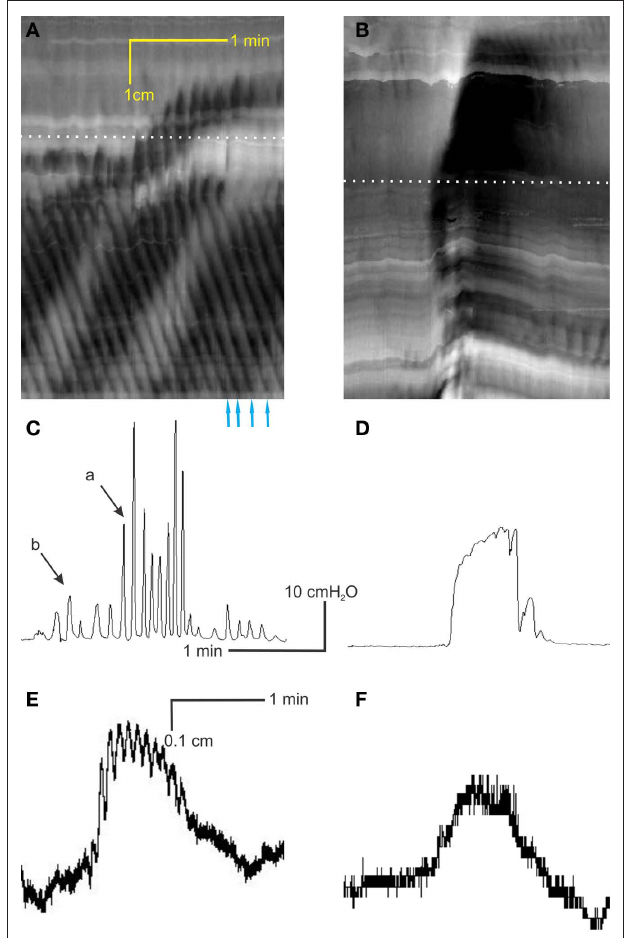
FIgurE 2 | Interaction between the two motor patterns. (A) The rhythmic propagating ripples are part of the rhythmic propulsive motor complexes. One can see a marked increase in amplitude (blackness) of the ripple contractions within the rhythmic propulsive motor complexes as compared to the time period in between these complexes. However, the propagation of the two types of activity appears independent. (B) When the rhythmic propulsive motor complexes are very strong, the rhythmic propagating ripples appear to summate and relatively long-lasting constrictions (broad black bands) occur. (C) Intraluminal pressure changes accompanying the rhythmic propulsive motor complexes in A at the dotted line. Strong intraluminal pressure changes occur during the rhythmic propulsive motor complexes but they consist of contractions at the rhythm of the rhythmic propagating ripples. (D) The rhythmic propulsive motor complexes are accompanied by strong intraluminal pressure increases. Here, the high frequency intraluminal pressure transients are seen to summate which leaves a single pressure change [occurring at the dotted line in (B) ]. (E) Presented here is a single line from the data file underlying (A) (at dotted line), showing in a different way the fact that the rhythmic propagating ripples have a much higher amplitude during the time frame of the rhythmic propulsive motor complexes than outside of that time frame. (F) Single line from data file underlying (B) at dotted